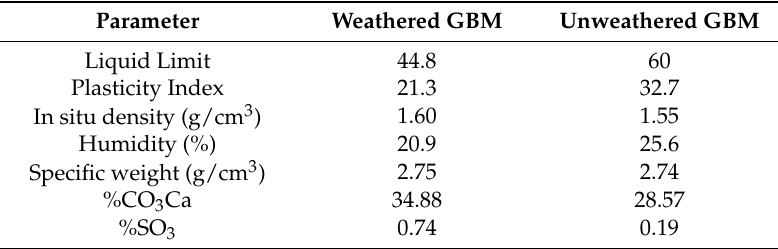
Table 1. Average physical/chemical parameters of a total of 17 Guadalquivir Blue Marls (GBM) weathered and unweathered samples taken along the Tablellina channel